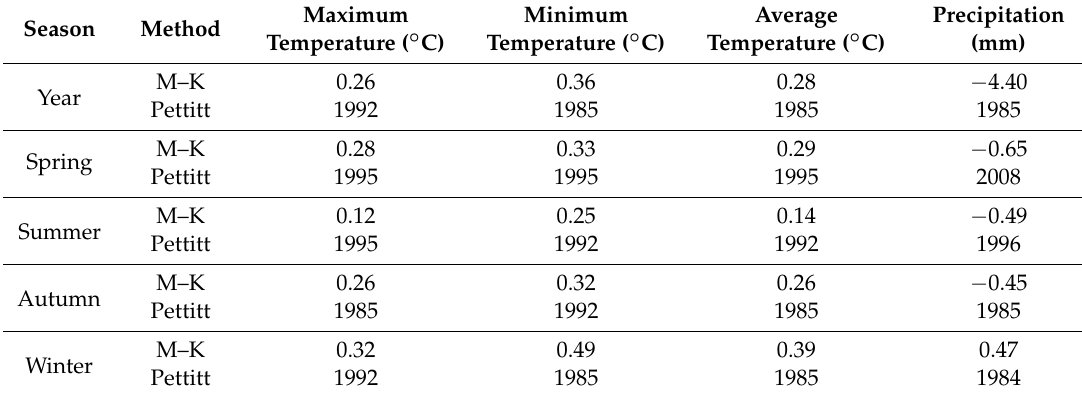
Table 2. Hydrothermal variability and abrupt changes in the Yellow River Basin from 1957 to 2015. M–K: